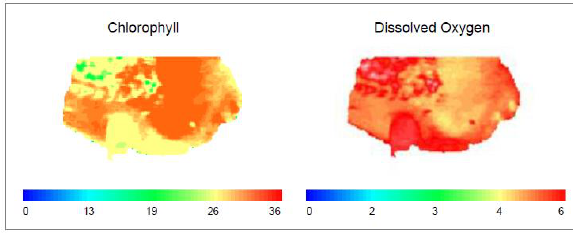
Figure 13 . Spatio-temporal Map of SMB (December